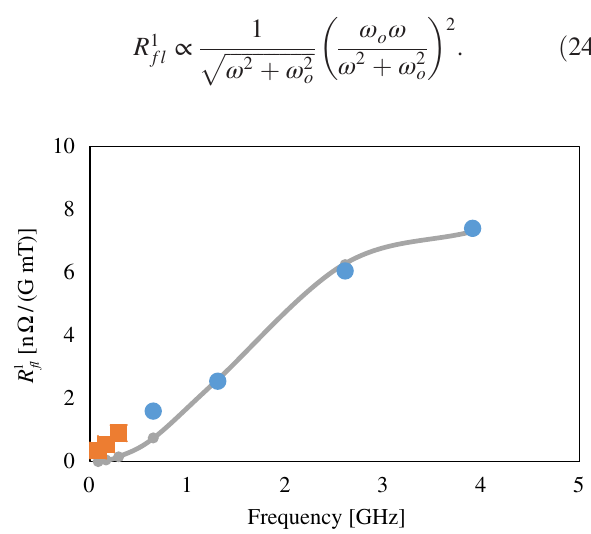
FIG. 4. Dependence of R 1 on the frequency. Data on Helix-II fl low-frequency resonators are from Ref. [3] (squares) and on 120 °C baked elliptical cavities from Ref. [7] (circles). The gray line is a best fit to the data, resulting in a depinning frequency ν ¼ ω 2 π ¼ 4 . 6 0 0 =